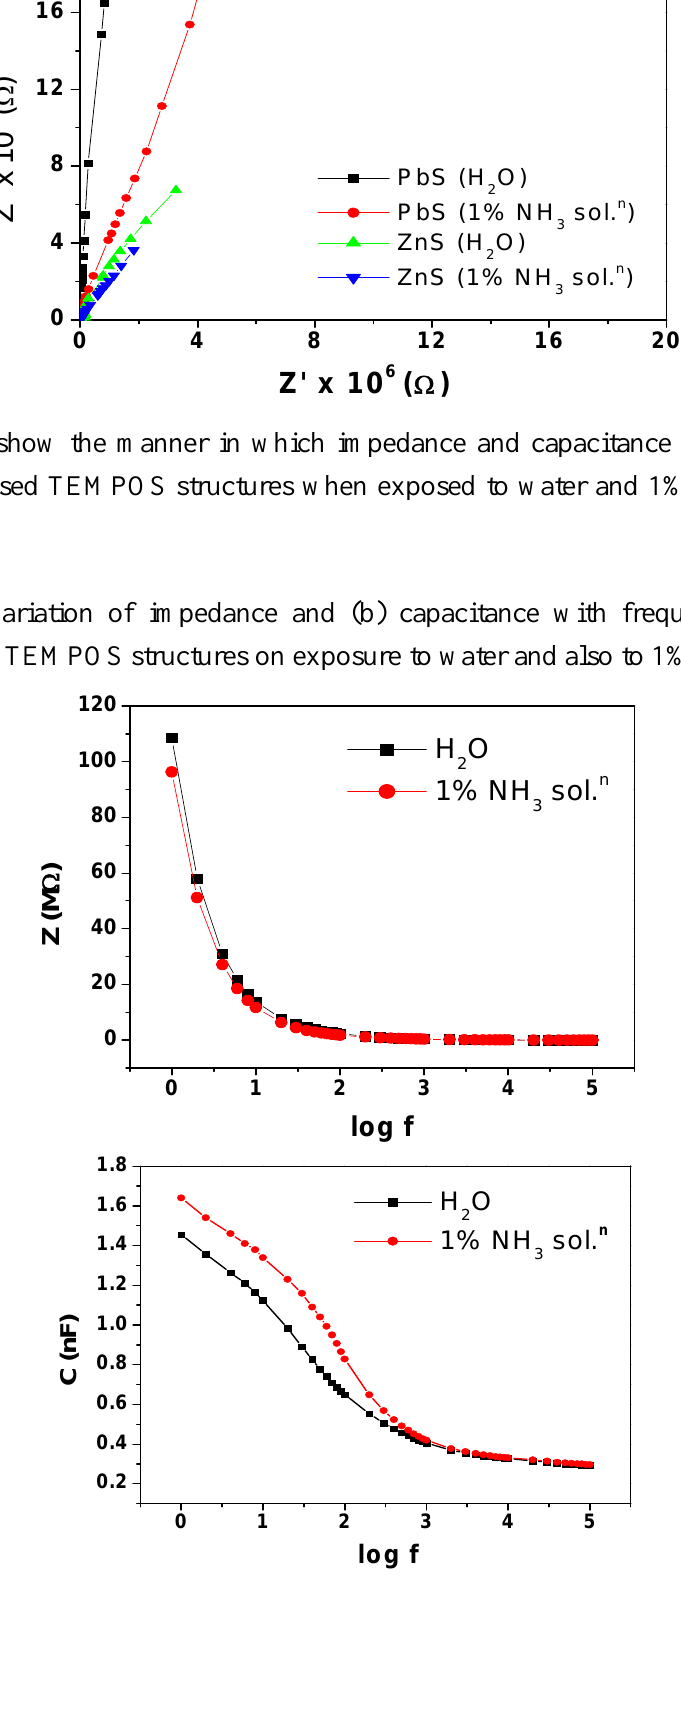
Figure 7. Cole-Cole plots of PbS dispersed PE and ZnS dispersed PE based TEMPOS structures with water and 1% ammonia solution.